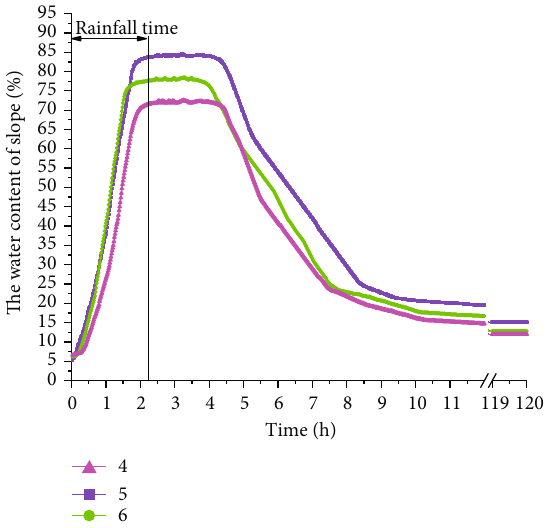
Figure 18: The changes of the slope displacement with